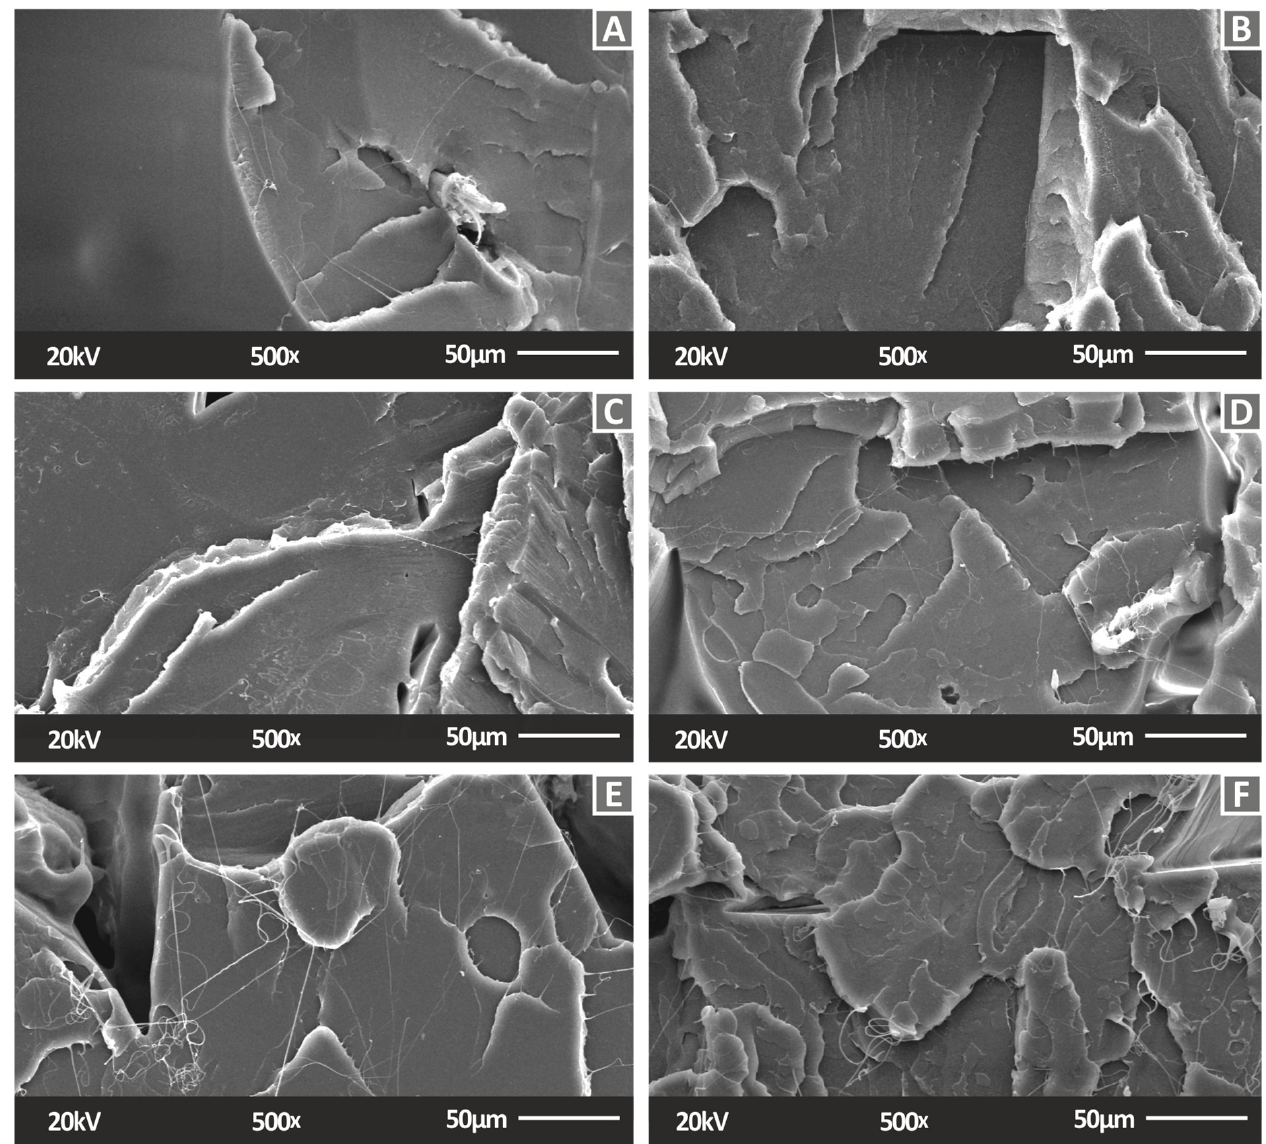
Figure 13. SEM images at 500× magnification for the fracture surface of the 3D-printed tensile specimens made with the nanocomposites tested in this work, PLA with: ( A ) 0.5 wt.% CNF, ( B ) 0.5 wt.% Cu 2 O, ( C ) 0.5 wt.% Cu 2 O and 0.5 wt.% CNF, ( D ) 0.5 wt.% Cu 2 O and 1.0 wt.% CNF, ( E ) 0.5 wt.% Cu 2 O and 2.0 wt.% CNF, and ( F ) 0.5 wt.% Cu 2 O and 3.0 wt.% CNF.